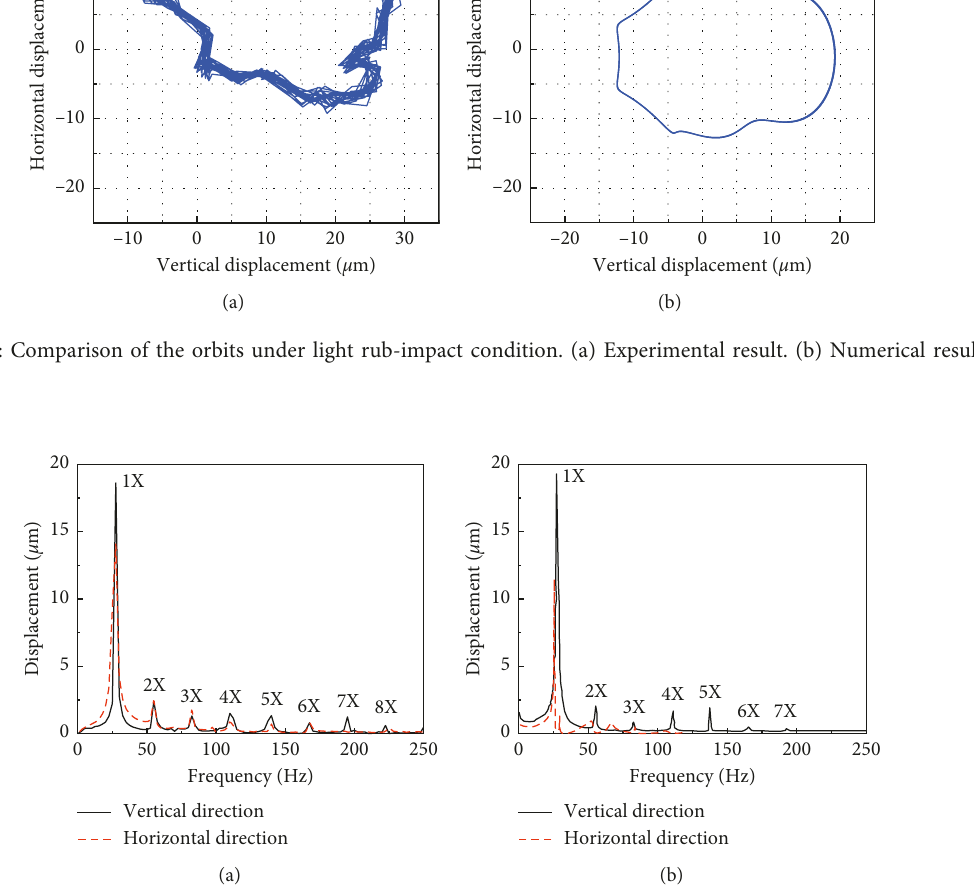
Figure 9: Comparison of dynamic response in frequency domain under light rub-impact condition. (a) Experimental result. (b) Numerical result.